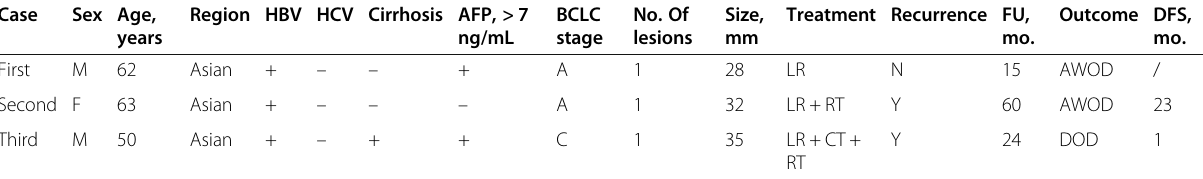
Table 1 Demographic and oncological characteristics of the 3